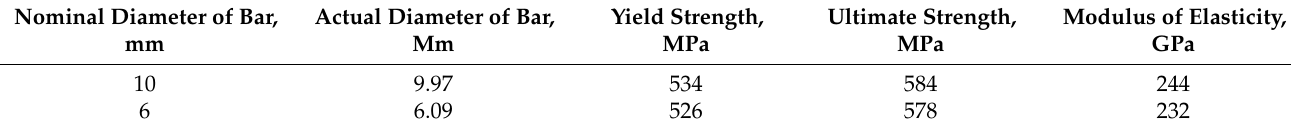
Figure 2. Reinforcement details of the specimen. Table 2. Properties of steel bars.